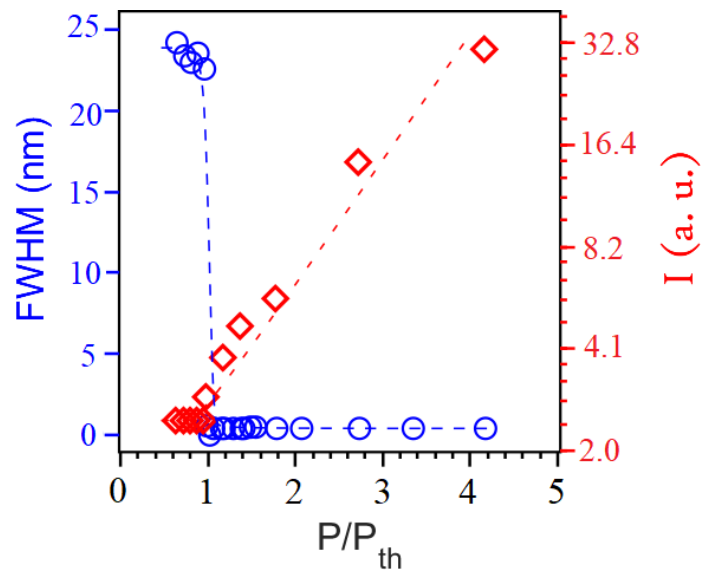
Figure 1. Linewidth narrowing (blue) and emitted intensity (red) of the random fiber laser (RFL) system as a function of normalized excitation power P / P th . The evident change of behavior in both measurements identifies the RFL threshold. The measured threshold value was P th = ( 16.30 ± 0.05 ) mW